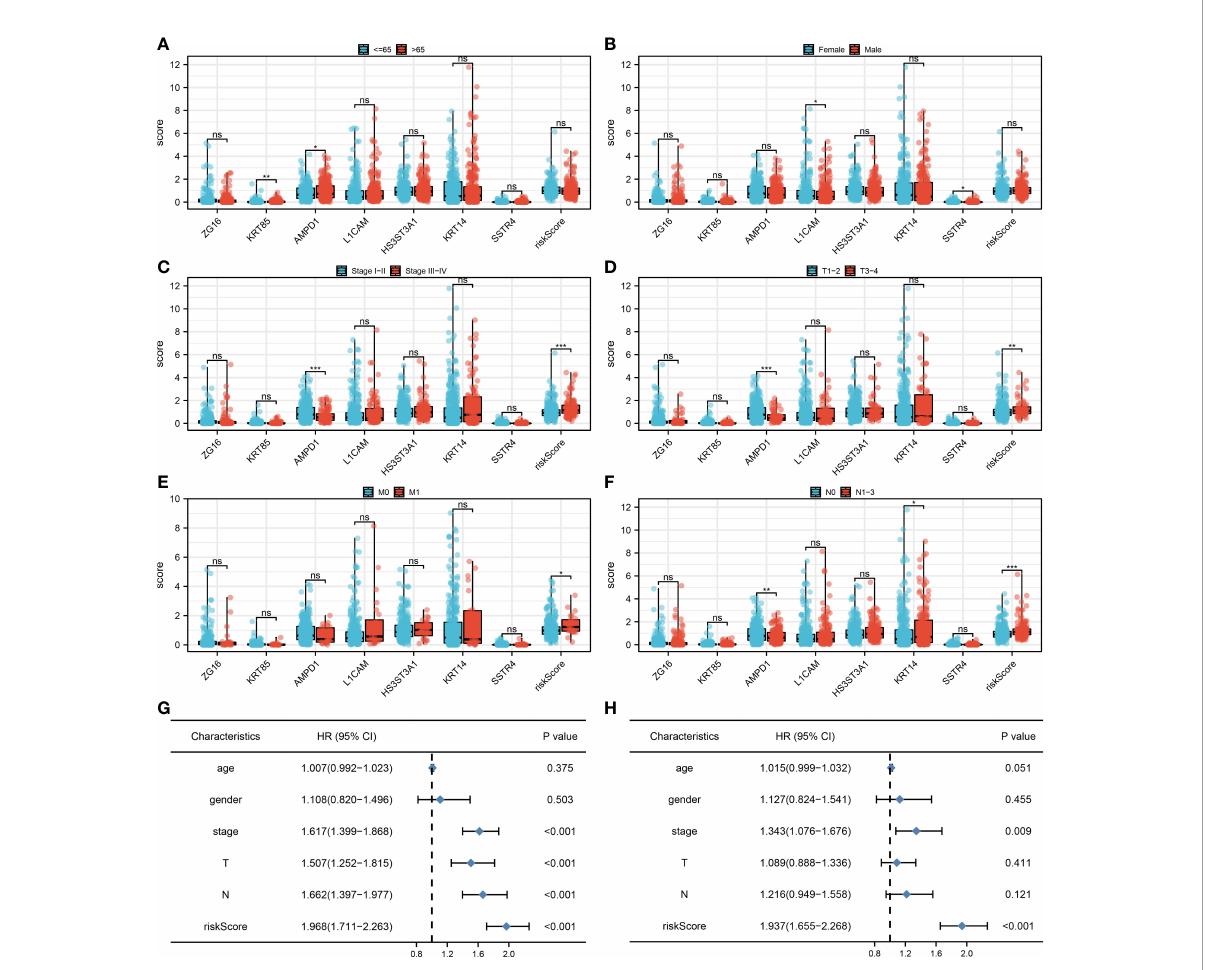
FIGURE 5 Clinical correlation. (A) The correlation analysis between age and expression level of seven characteristic molecules, ns P > 0.05, *P < 0.05, **P < 0.01; (B) The correlation analysis between gender and expression level of seven characteristic molecules, ns P > 0.05, *P < 0.05; (C) The correlation analysis between stage and expression level of seven characteristic molecules, ns P > 0.05, ***P <0.001; (D) The correlation analysis between T stage and expression level of seven characteristic molecules, ns P > 0.05, **P < 0.01, ***P <0.001; (E) The correlation analysis between M stage and expression level of seven characteristic molecules, ns P > 0.05, *P < 0.05; (F) The correlation analysis between N stage and expression level of seven characteristic molecules, ns P > 0.05, *P < 0.05, **P < 0.01, ***P <0.001; (G) The univariate independent prognostic analysis revealed that stage, T stage, N stage and risk score are independent prognostic factors in LUAD patients; (H) The multivariate independent prognostic analysis reveals that stage and risk score are independent prognostic factors in LUAD